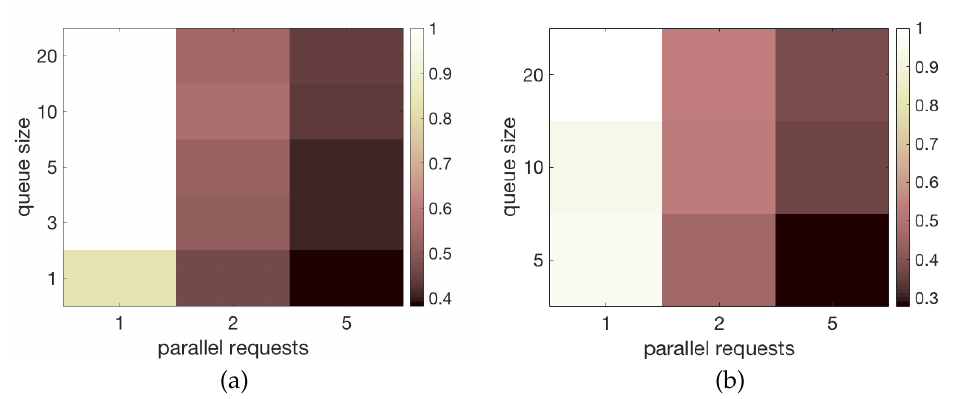
Figure 7. Transmission efficiency with different FreeRTOS queue sizes. ( a ) Without acknowledgment. ( b ) With